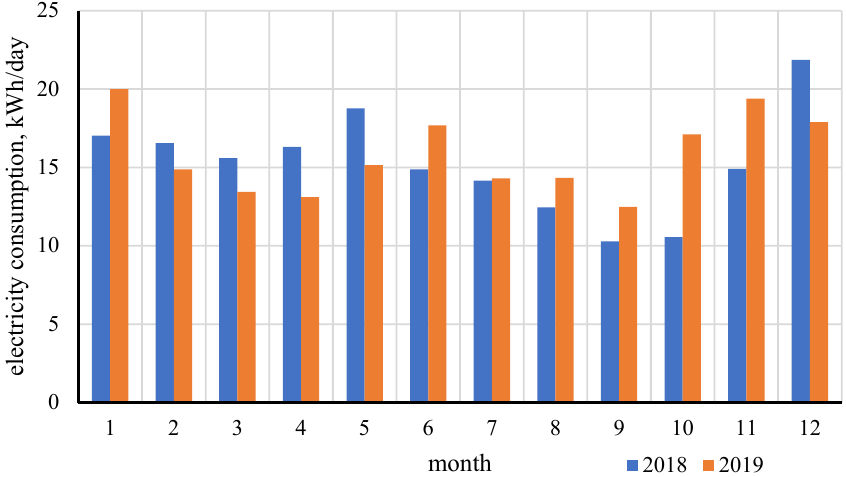
Figure 7. Average daily electricity consumption in AB in individual months of 2018 and 2019.